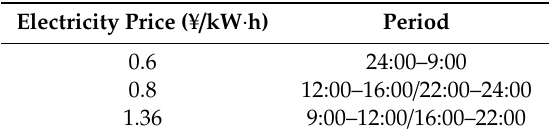
Table 3. Electricity price for each period of electricity purchased from the power grid.